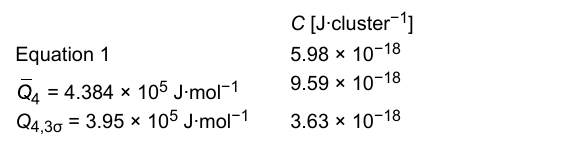
Table 2: Parameter C for calculating the surface energy γ . For the ap- proach using the Kelvin equation, two parameters are given to charac- terize the 3 σ scattering range for the exact